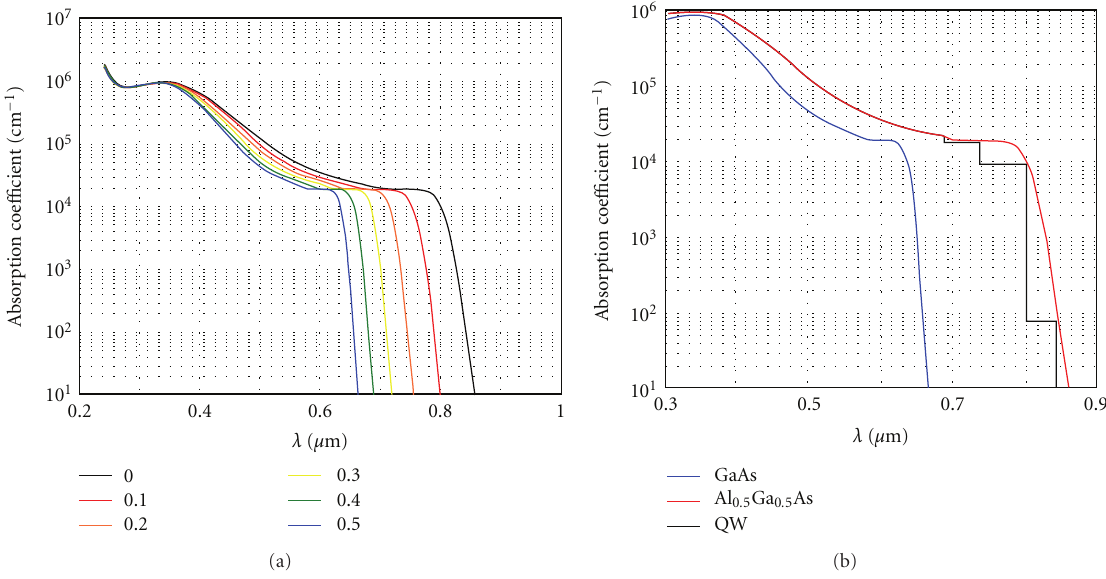
Figure 6: (a) Absorption coe ffi cient of Al x Ga 1 − x As depending on wavelength; x is the curves parameter. (b) Absorption coe ffi cient in GaAs crystal; the ternary compound Al 0 . 5 Ga 0 . 5 As is calculated using axes translation in MQW